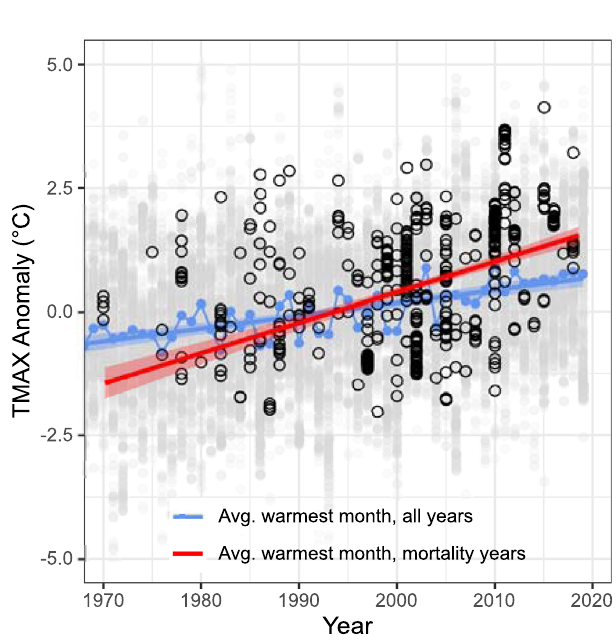
Fig. 5 Mortality year TMAX warming faster than all years. Linear regressions showing the trend of TMAX anomalies during the typically warmest month across all years (1970 – 2018, blue trend line is model fi t of the linear regression) and mortality event years in the database (red trend line is model fi t of the linear regression, as in Supplementary Fig. S7A). Blue dots show the mean values for TMAX anomaly during the typically warmest month, for all years at all sites, and the faded gray dots the raw data. Black open circles indicate mortality year TMAX anomalies for each site. For both regressions, gray shading represents the standard error of model fi t. TMAX Anomalies are increasing faster during mortality event years (red line), than during the chronic background warming illustrated by the all-years, all-sites regression